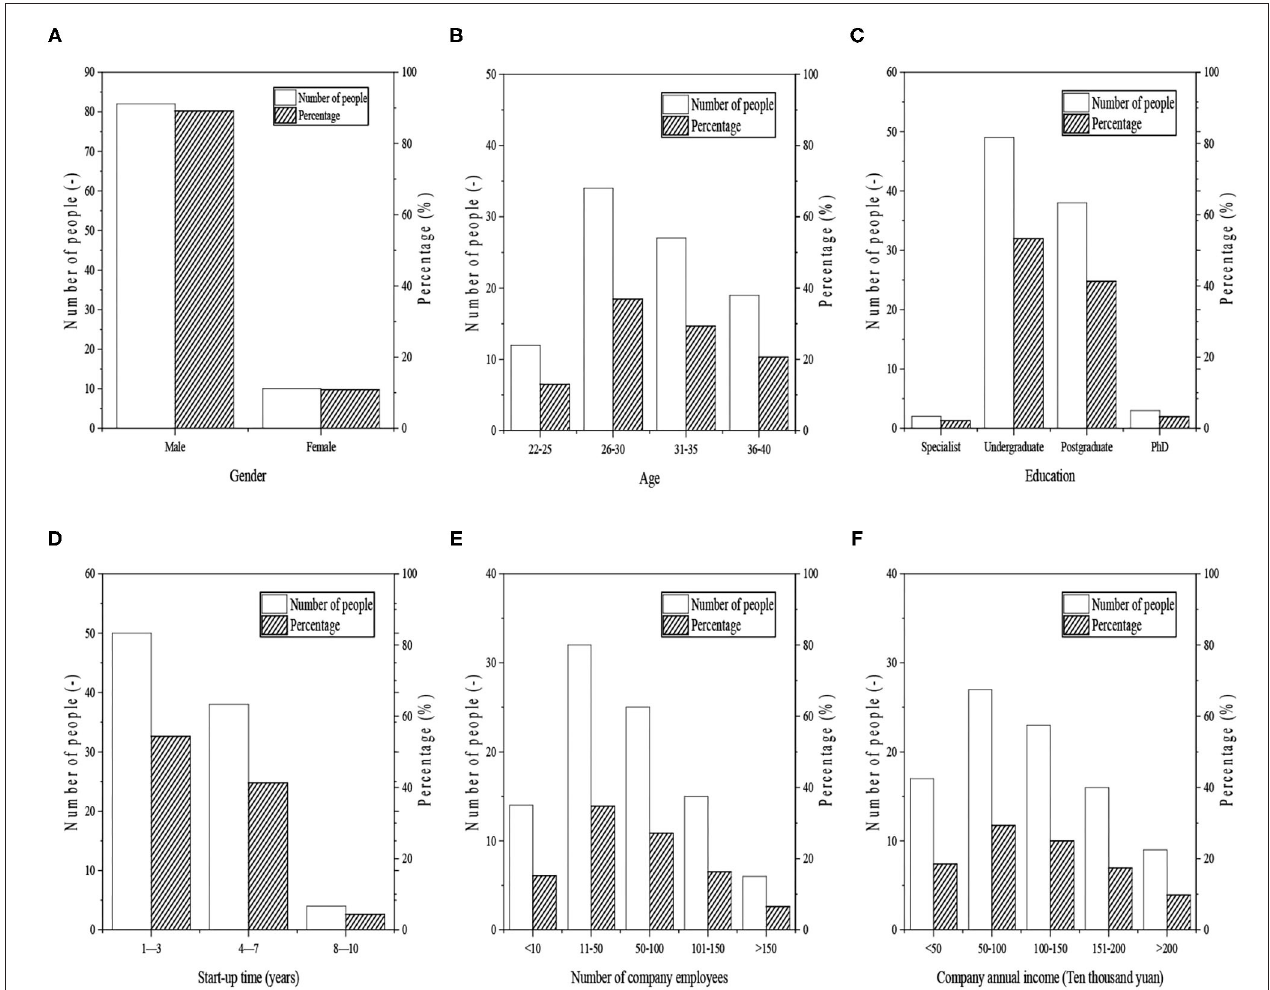
FIGURE 4 | Summary and analysis of surveyed college-student